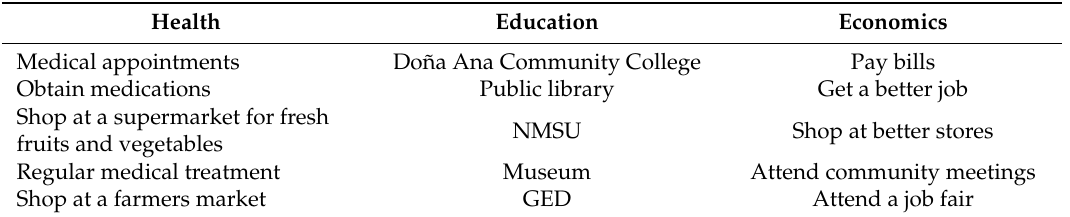
Table 2. The top five reasons for using the bus service for each general category of use.